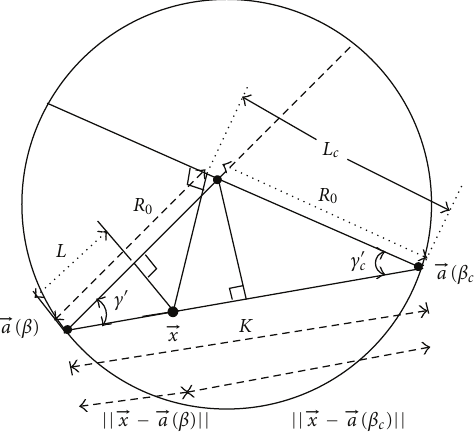
Figure 4: Illustration of a fan-beam scanning geometry showing redundantly measured line integral along line K . The line integral along K corresponds to source positions a ( β ) and a ( β c ).